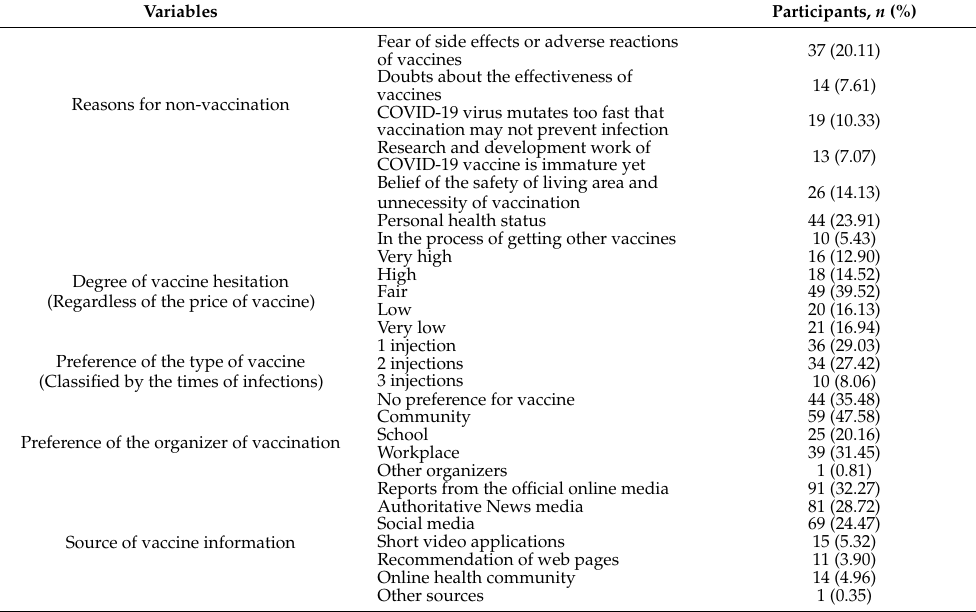
Table 3. Characteristics of Unvaccinated Participants ( n =